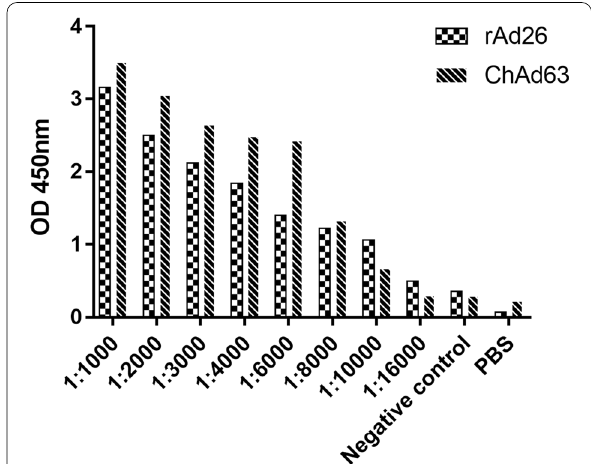
Fig. 2 The serum antibody titer of immunized Bactrian camels was measured using ELISA. Polystyrene microplates were coated with rAd26 and ChAd63 viruses. The immune serum of the camel was diluted with PBS, basal serum was used as a negative control, and PBS was used as a blank control. The binding activity of each well was detected using an HRP-labeled goat anti-alpaca antibody at a 1:10,000 concentration and visualized with TMB solution. The plate was read at OD450 nm in a microplate